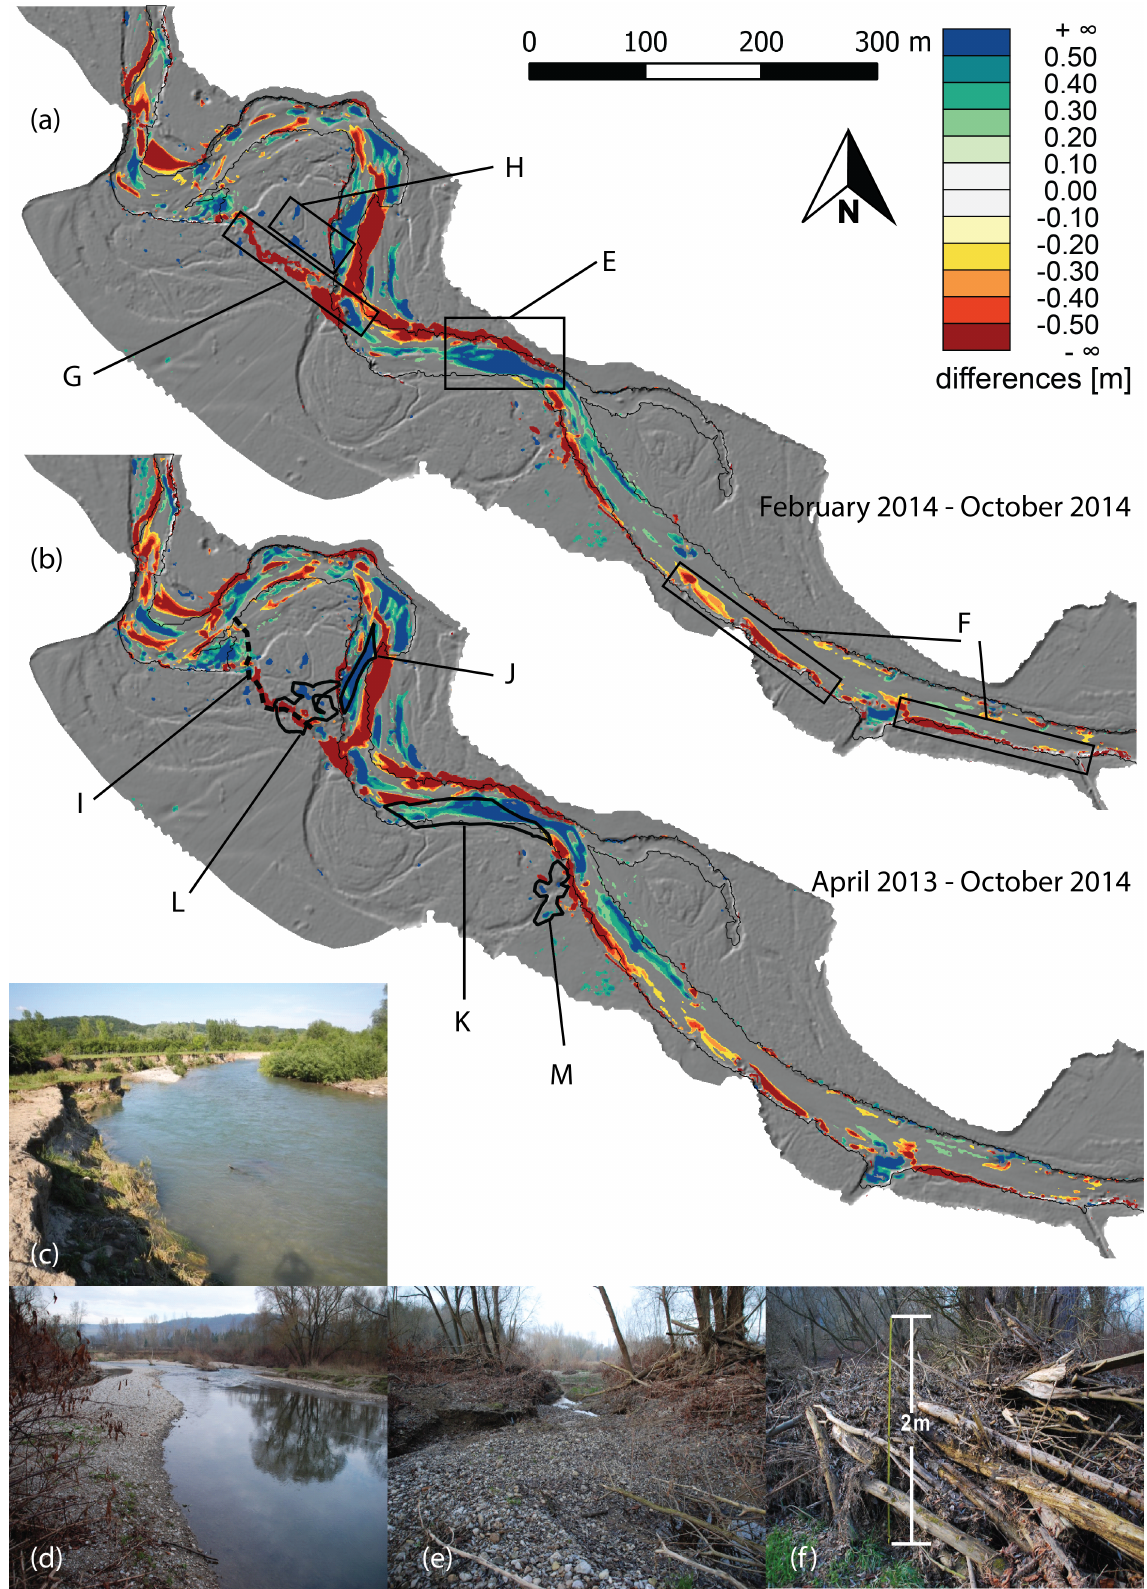
Figure 11. Color-coded visualizations of the masked DoD in front of the hillshade of the more recent epoch. ( a ) Impact of 30-years flood in May 2014; ( b ) Total impact of the entire studied period, Photo documentation of morphodynamics; ( c ) bank erosion ( i.e. , detail B in Figure 10a); ( d ) gravel bank relocation (detail E in Figure 11a); ( e ) new meander shortcut channel (detail G); ( f ) deadwood pile (detail